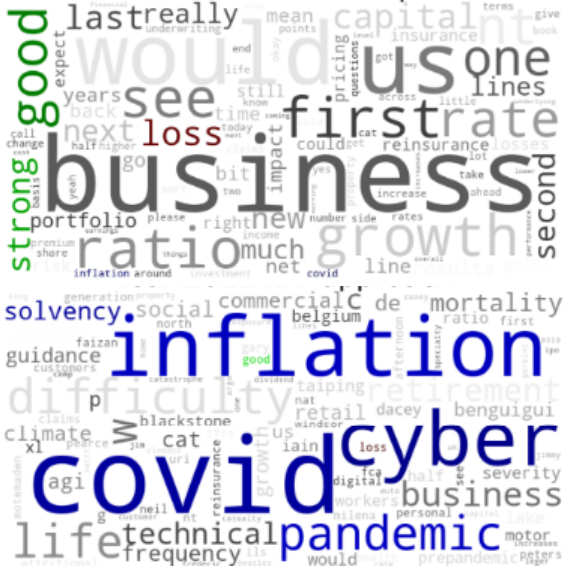
Figure 2. Combining word clouds and TF-IDF scores. Note: words are coloured according to their polarity—green positive, red negative, grey neutral. Words in blue highlight those selected for